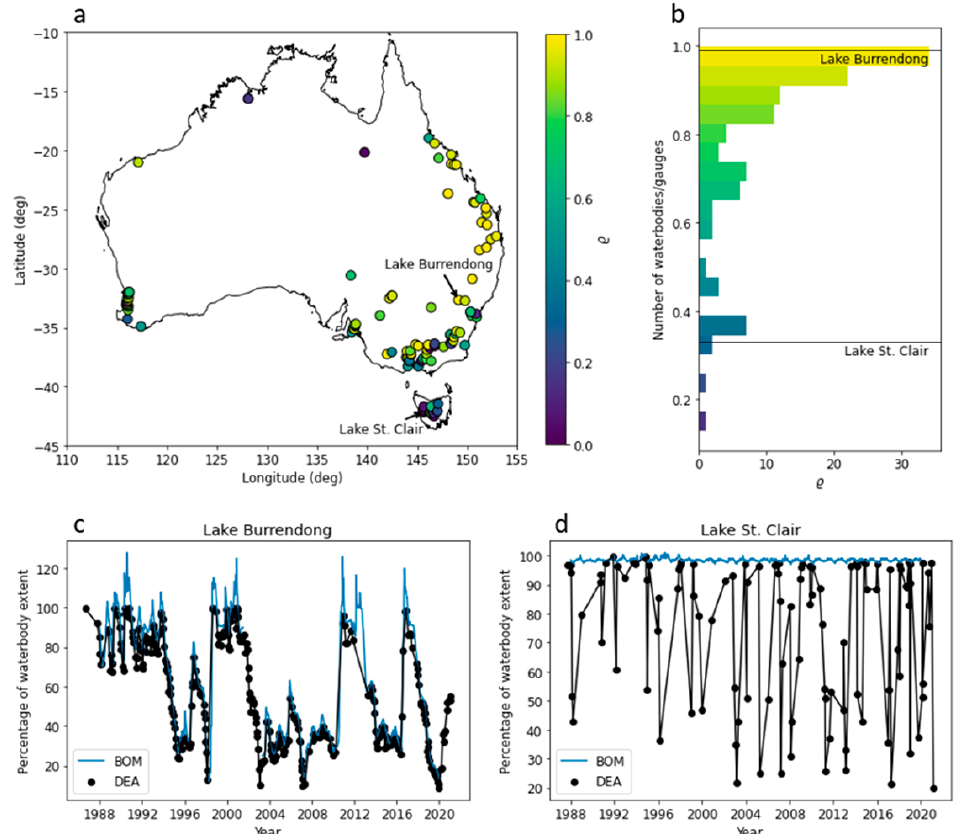
Figure 7. Validation of DEA Waterbodies time series. ( a ) Spearman ρ coefficients from the DEA Waterbodies/WDO time series comparison. Waterbodies/gauges used to validate the DEA Water- bodies time series, coloured by the Spearman ρ coefficient of the relationship. ( b ) Distribution of Spearman ρ coefficients for all analyses. The individual gauges and their corresponding ρ are given in Appendix C, in Table A1. ( c ) Lake Burrendong surface area in DEA Waterbodies and estimated from WDO. ( d ) Lake St. Clair surface area in DEA Waterbodies and estimated from WDO. The surface areas in ( c , d ) are scaled as a percentage of maximum waterbody extent in DEA Waterbodies. To help visualise the comparison between WDO and DEA Waterbodies, we estimated the surface area time series for each WDO volume time series using the volume and depth gauge data. Figure 7c and d show the estimated WDO surface area time series plotted alongside the DEA Waterbodies surface area time series for Lake Burrendong (New South Wales) and Lake St. Clair (Tasmania) respectively. The Burrendong time series (Figure 7c) shows very close agreement between the surface area time series